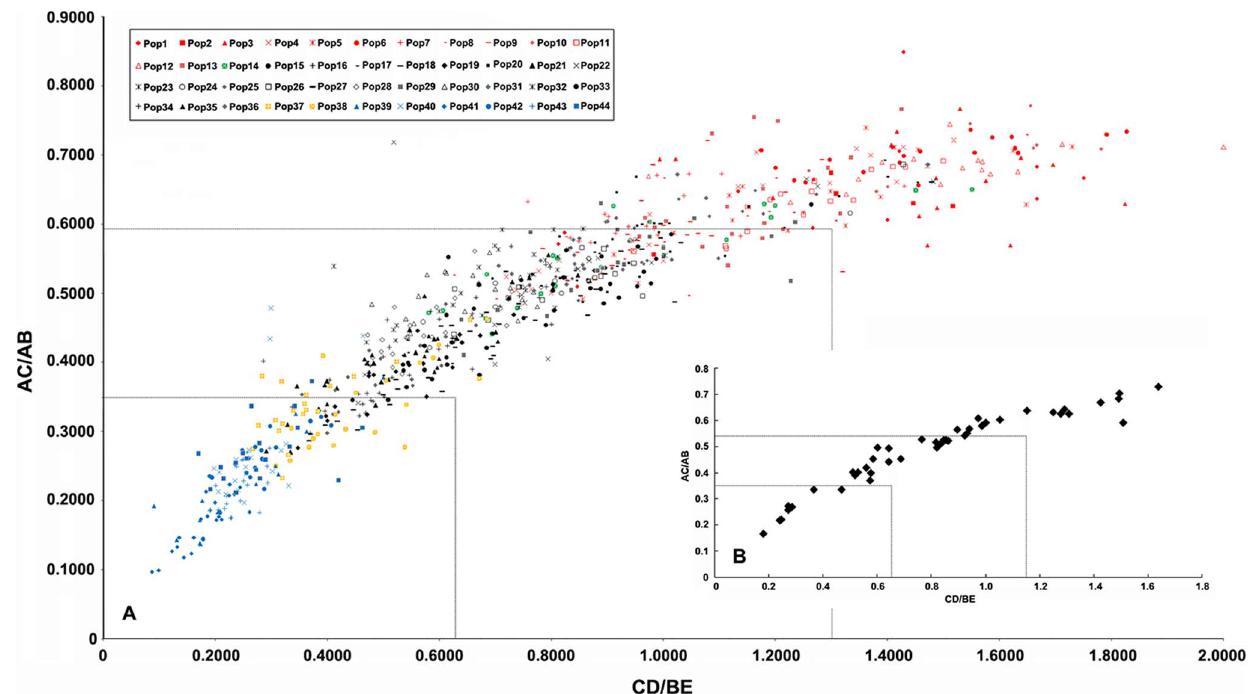
Figure 3. The scatter diagrams of AC/AB and CD/BE at the individual (A) and population (B) levels.